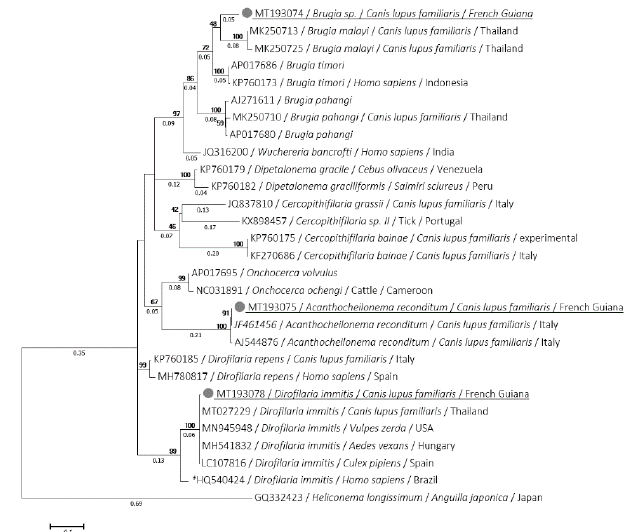
Figure 3. Phylogram of the cox 1 gene generated by maximum likelihood method from 29 partial (449) sequences. The tree with the highest log likelihood ( − 2690.9892) is shown. A discrete Gamma distribution was used to model evolutionary rate differences among sites (5 categories (+G, parameter = 0.4403)). Numbers above and below branches are the display of bootstrap replicate values and branches length, respectively. Host, geographical location (when available) and GenBank accession number are indicated in each node. The sequences of the present study are underlined. *: indicates the most virulent strain of D. immitis from Latin America [39].